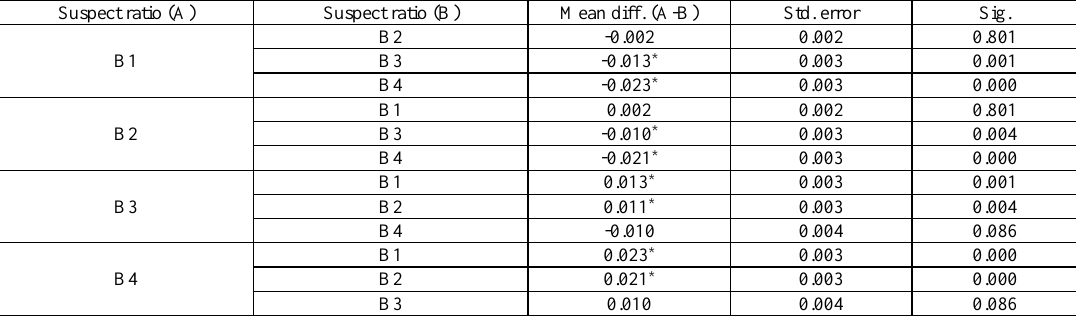
Table 1. Games-Howell multiple